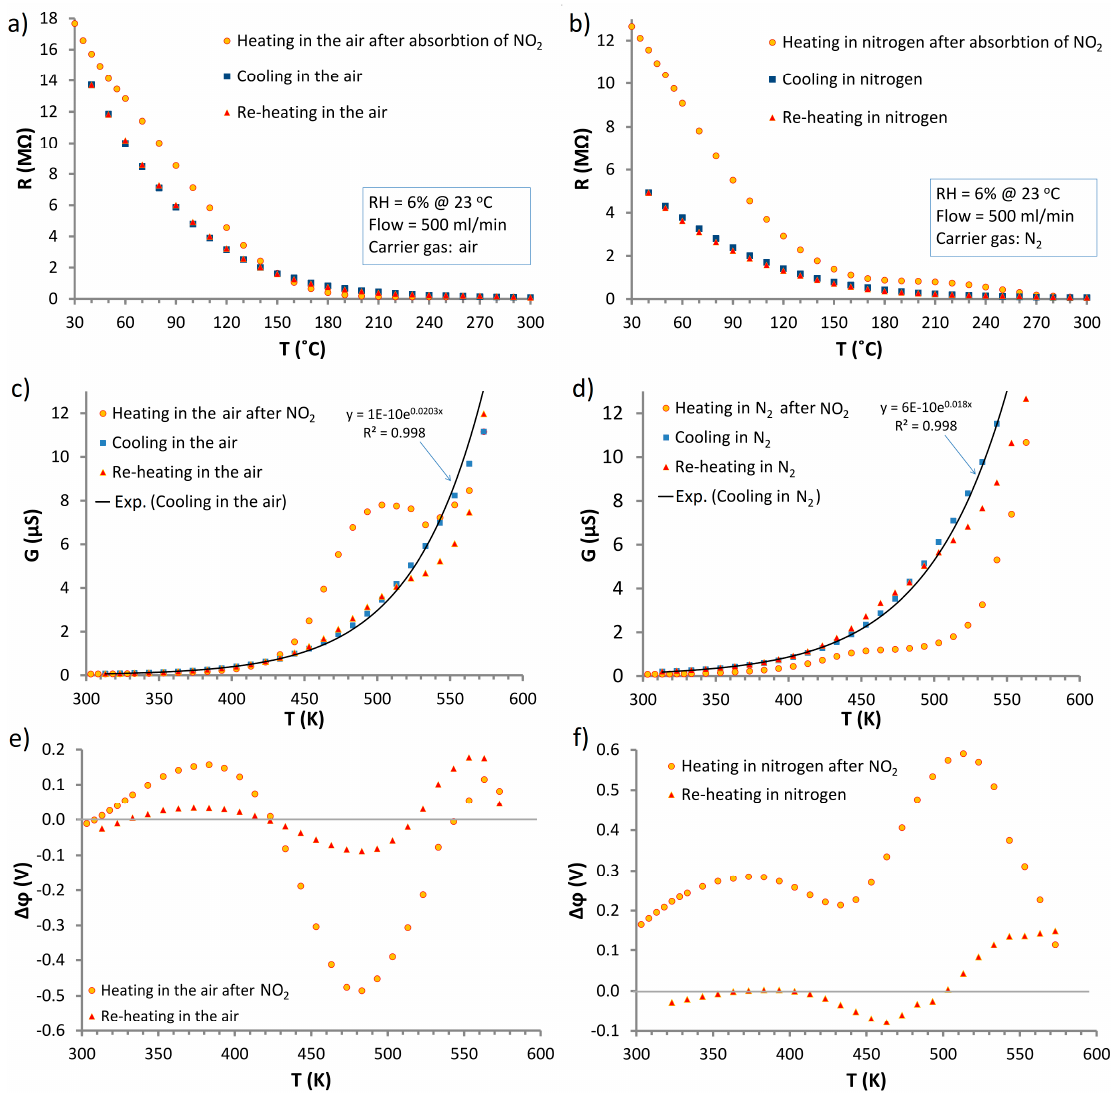
Figure 4. Temperature dependences of: ( a , b ) resistance; ( c , d ) conductance; ( e , f ) surface potential; for ZnO nanostructures saturated by NO 2 at RT and then heating, cooling and re-heating in air and nitrogen.